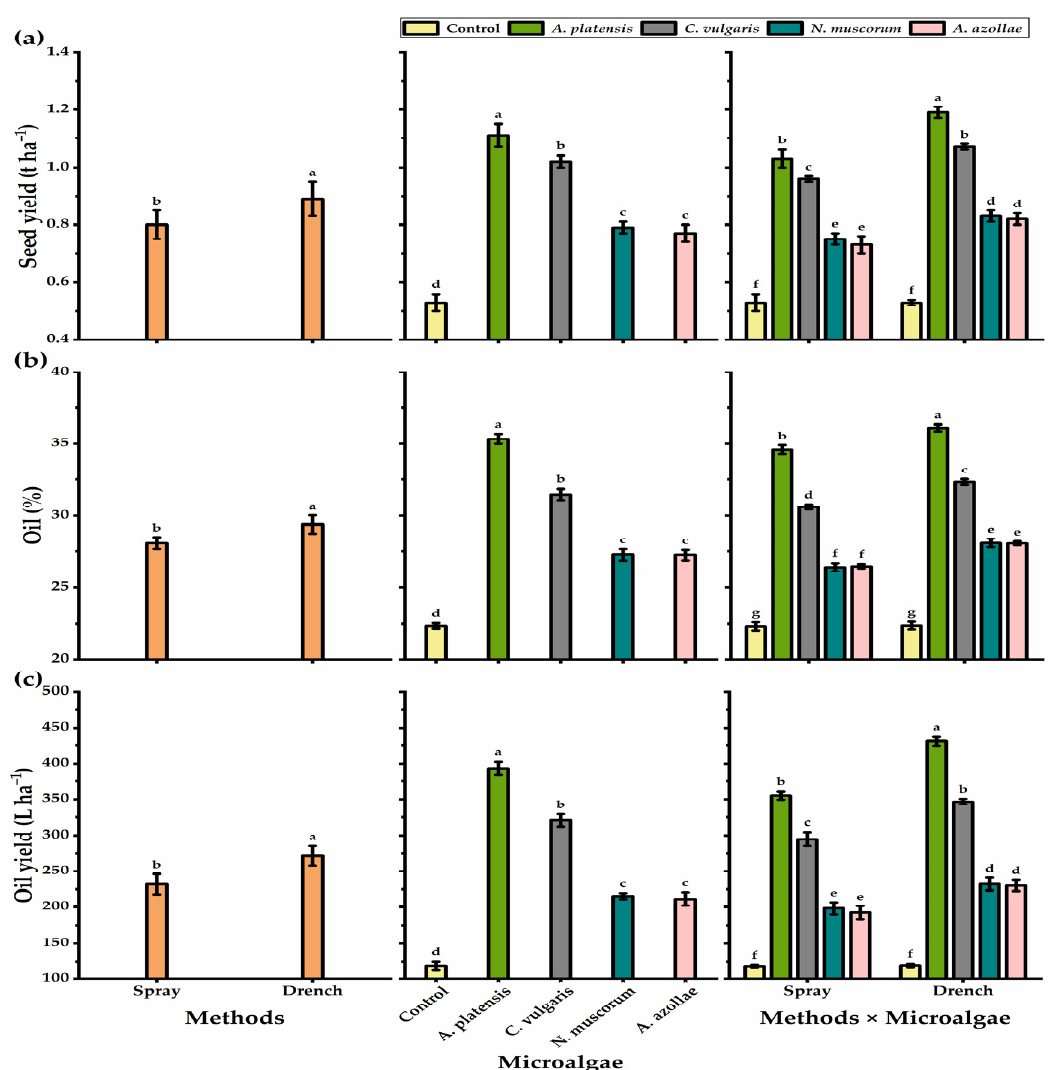
Figure 1. Seed yield ha − 1 (t) ( a ), oil % − 1 ( b ), and oil yield ha − 1 (L) ( c ) of chia plants cultivated under alkaline stress conditions in response to different application methods, microalgae strains, and their interaction. The bars with different letters are significantly different at p ≤ 0.05 by DMRT. Mean values are presented as mean ± standard error.